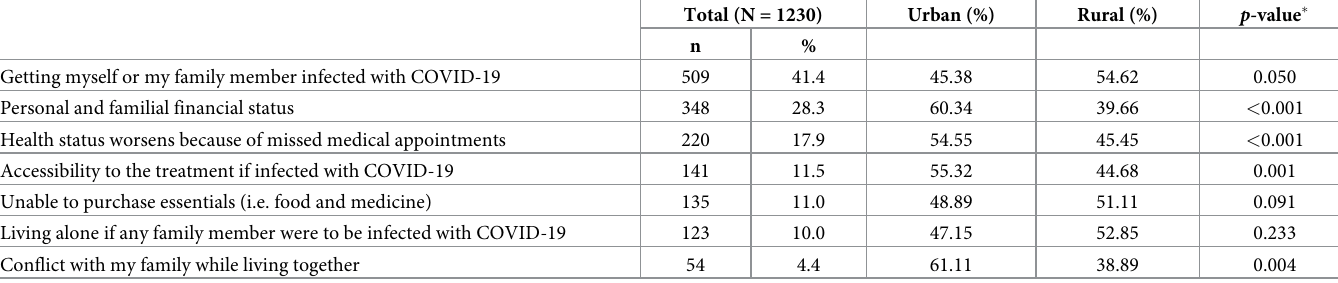
Table 2. Worries regarding the COVID-19 situation among older